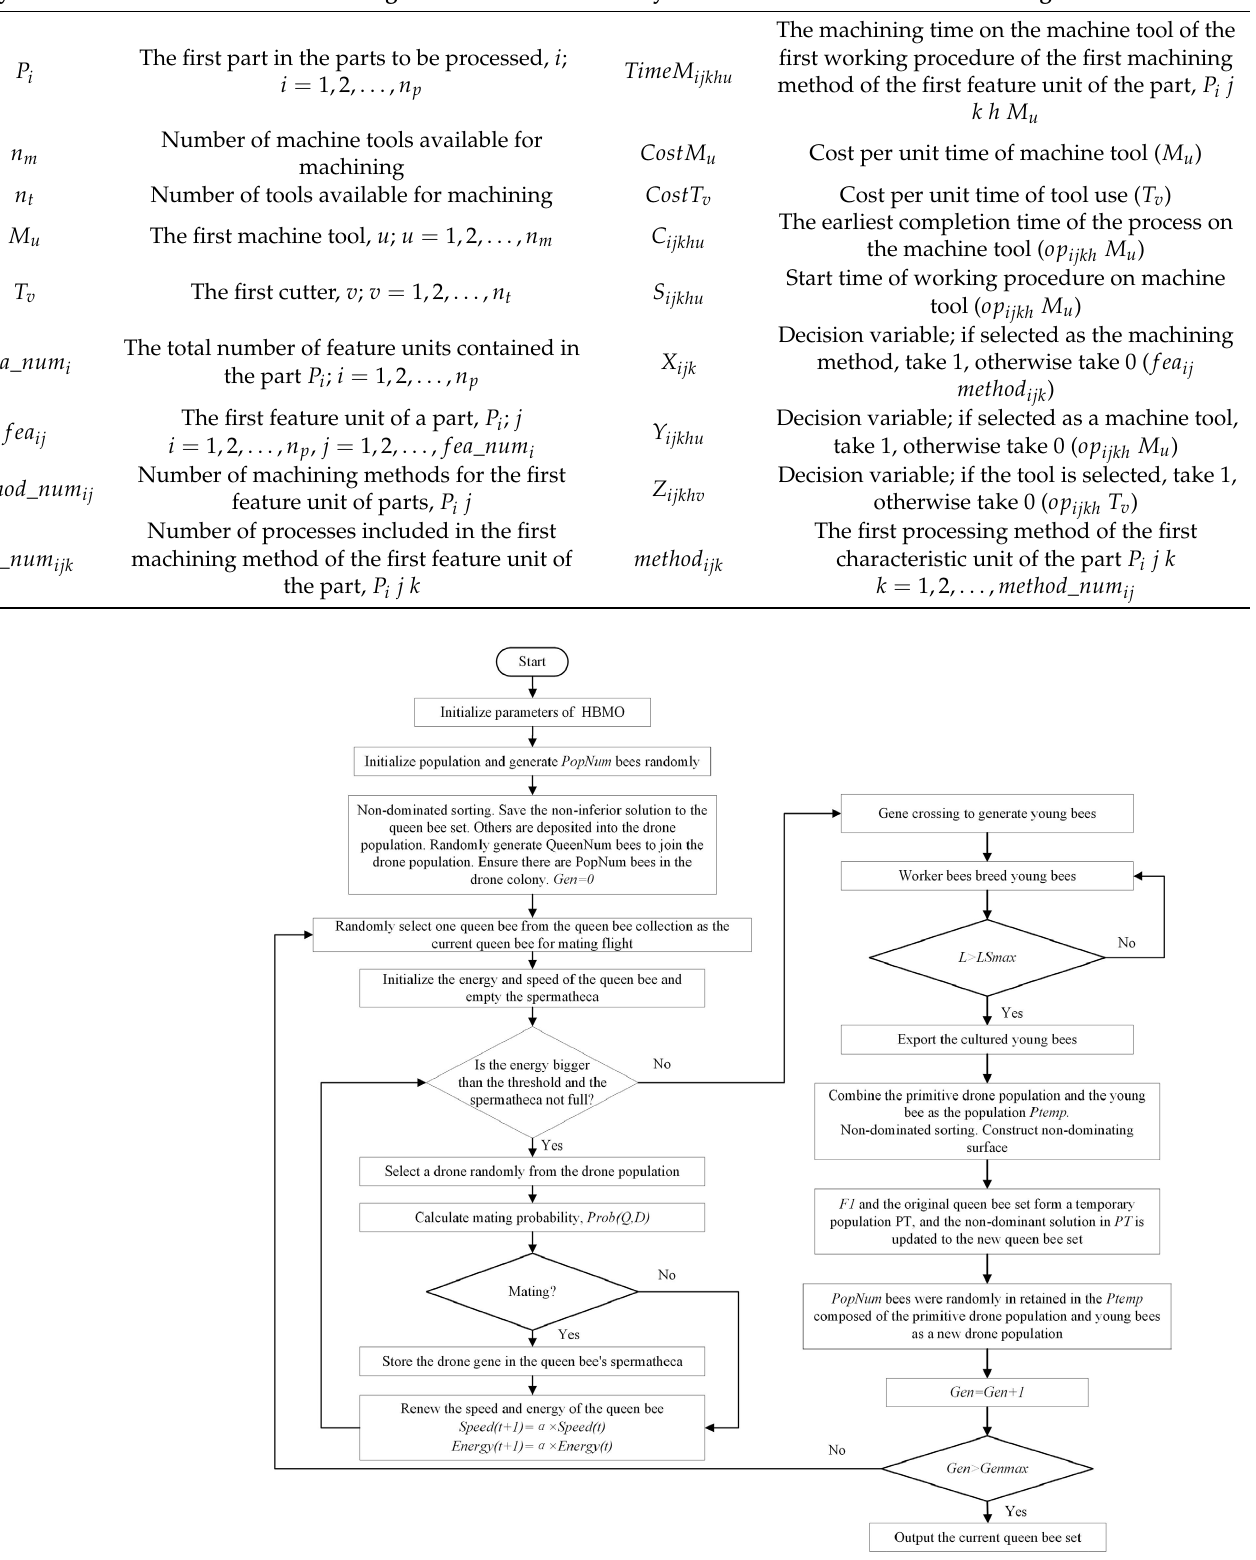
Figure 1. HBMO fl ow chart for solving process reconfiguration model of aerospace complex com- Figure 1. HBMO flow chart for solving process reconfiguration model of aerospace complex compo- ponents.